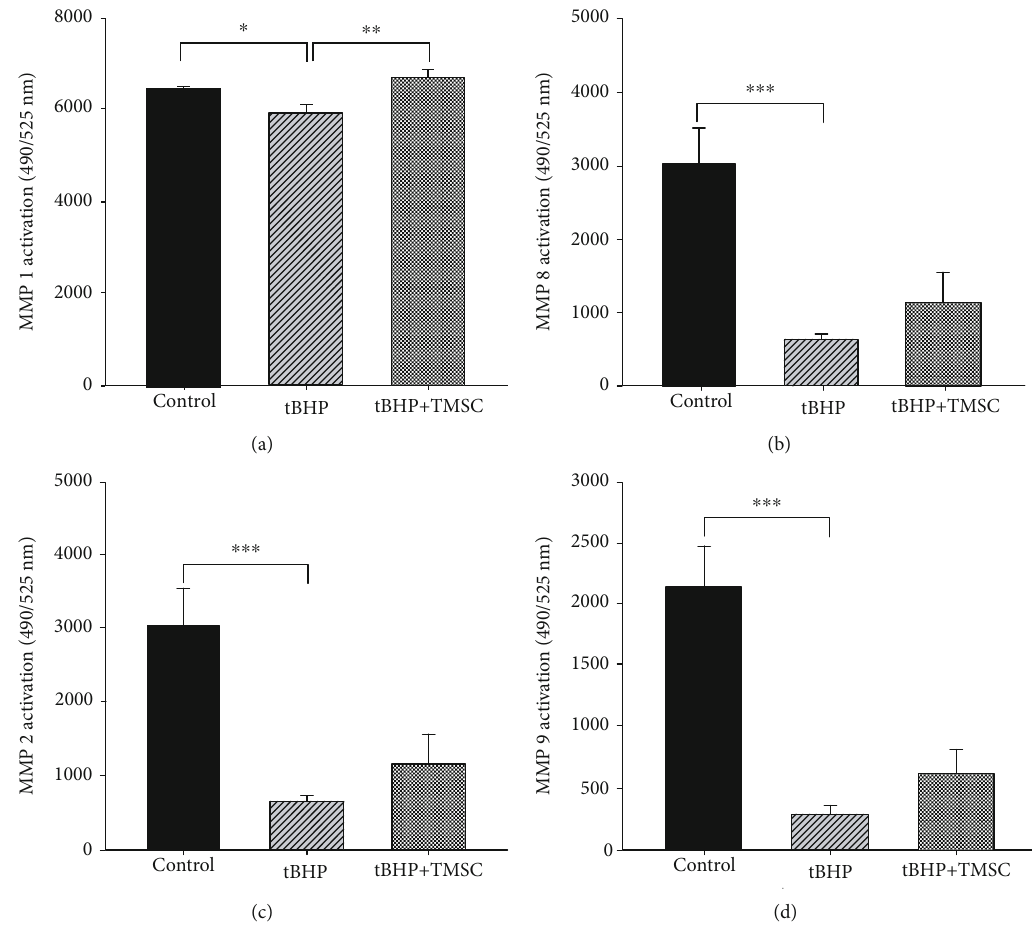
Figure 6: Matrix metalloproteinase (MMP) activity assay. (a – d) Treatment with tBHP slightly suppressed the activity of MMP 1 and strongly inhibited those of MMPs 8, 2, and 9. The activities of all MMPs were signi fi cantly restored after coculturing with TMSCs. Results are 3 technical replicates of TMSC from one donor. Representative results from two di ff erent TMSCs with similar tendency were presented. For multigroup comparison, ANOVA followed by the Bonferroni post hoc test was used for statistics. Results are shown as the mean ± SD . ∗ P < 0 : 05 , ∗∗ P < 0 : 01 , ∗∗∗ P < 0 : 001